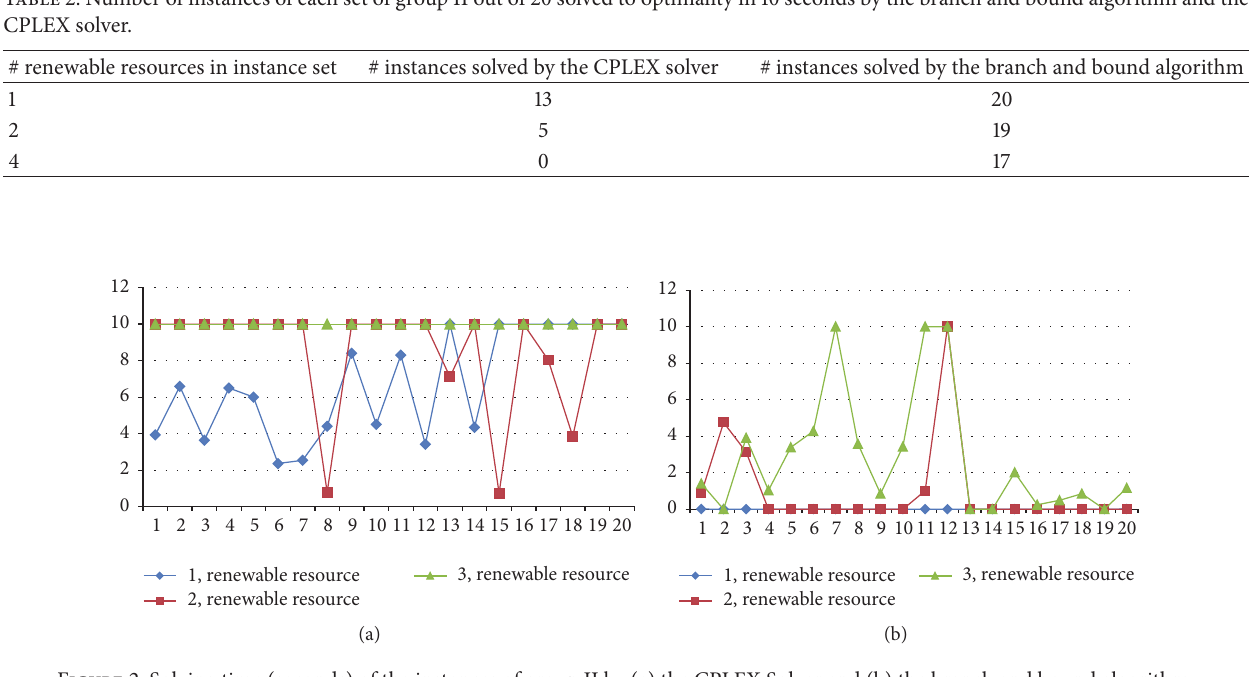
Figure 2: Solving time (seconds) of the instances of group II by (a) the CPLEX Solver and (b) the branch and bound